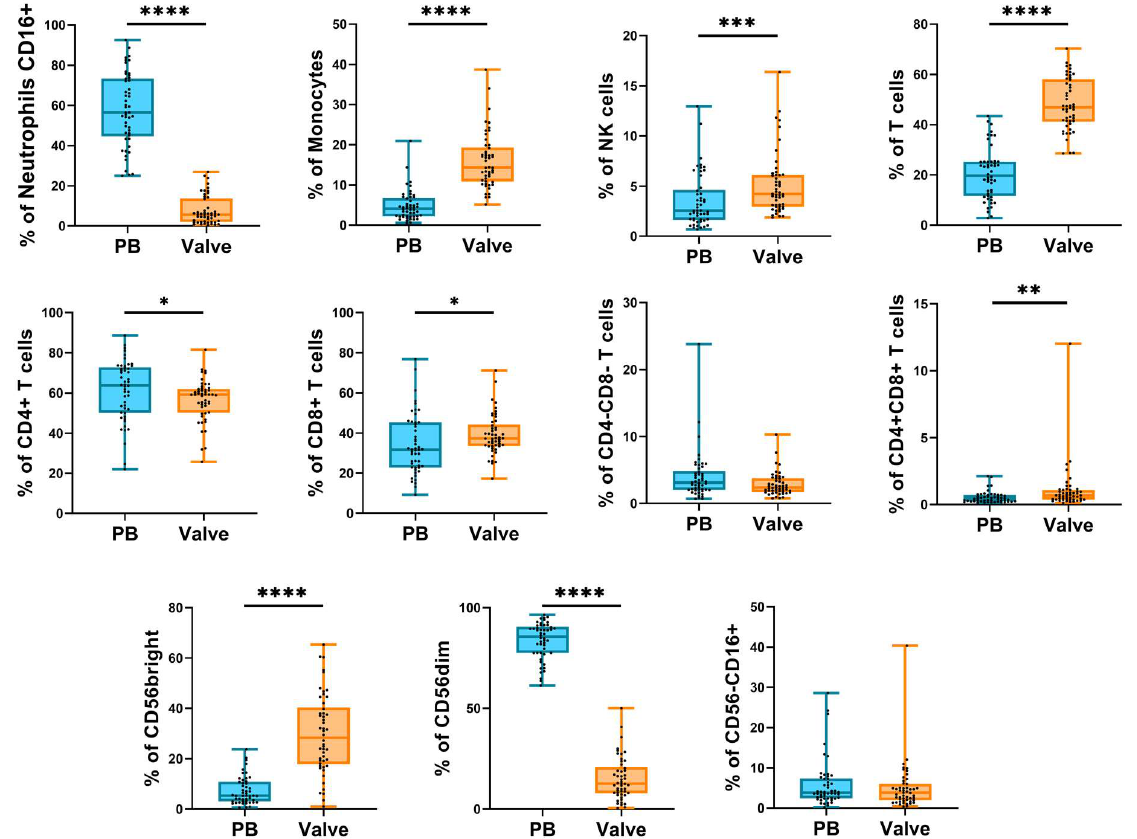
Figure 2. Frequencies of innate and adaptative leukocyte subpopulations. Boxplot graphs showing the frequencies of innate and adaptative cell subsets from peripheral blood (blue) and valvular infiltrate (orange). Frequencies were calculated from the total number of leukocytes. The horizontal bar shows the median and whiskers show the maximum and minimum values. Each dot represents a donor. The significance of the data was determined by the Mann–Whitney comparison test. * p < 0.05, ** p < 0.01, *** p < 0.001, and **** p < 0.0001.